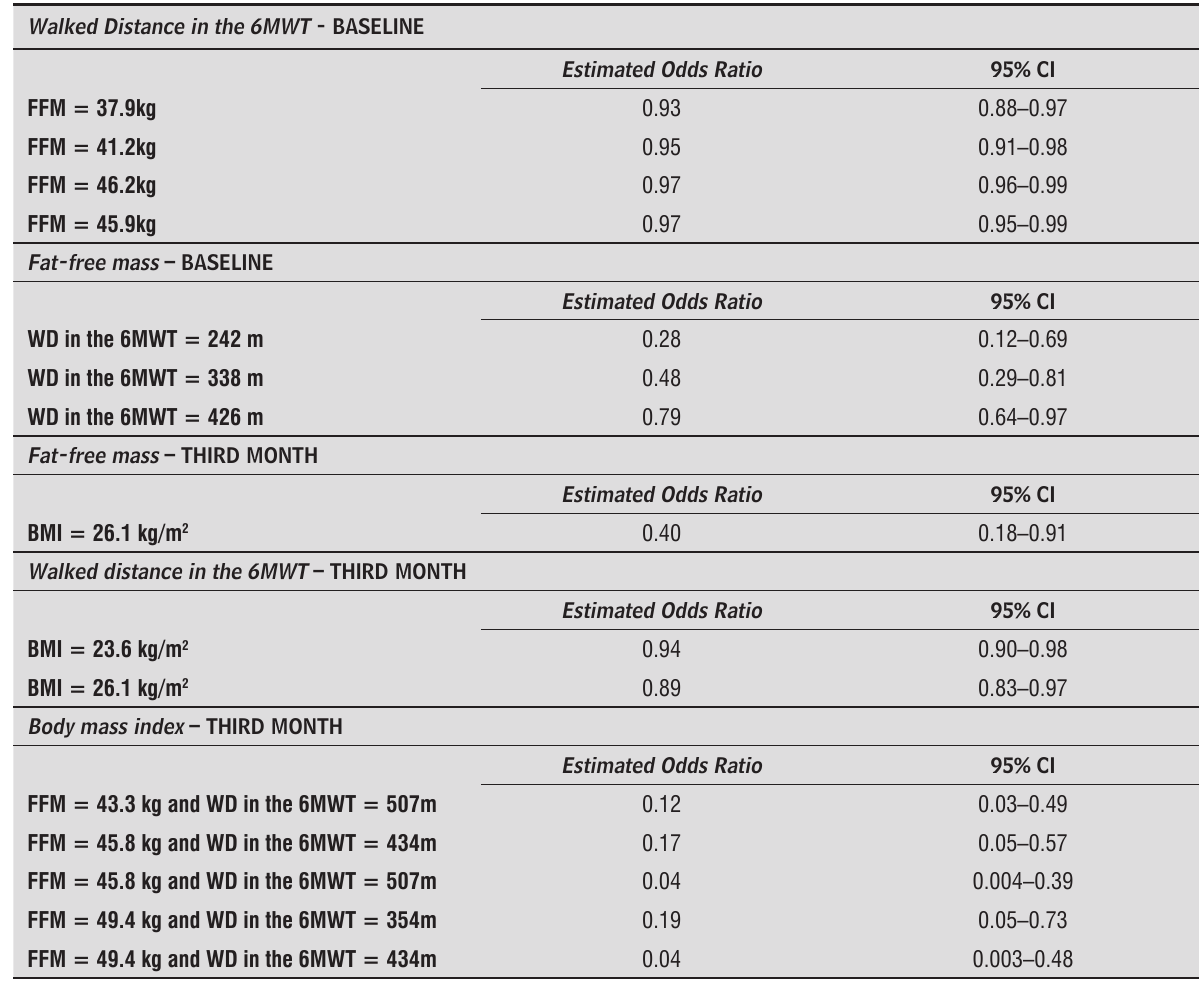
Table 3 - Interaction of the walked distance in the 6MWT with the FFM presented in estimated odds ratio and its 95 % confidence interval in the assessment and interaction of the body mass index with the fat-free mass, as well as the walked distance in the 6MWT after a three-month